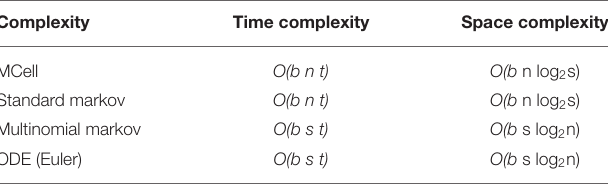
TABLE 2 | Space and time complexity for the various simulation strategies. Complexity Time complexity Space